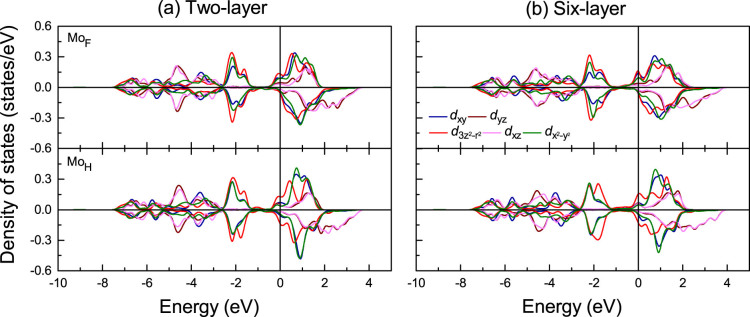
DOS of the Mo atoms at the F and H sites for the two- and six-layer Gd/MoS2 interfaces.